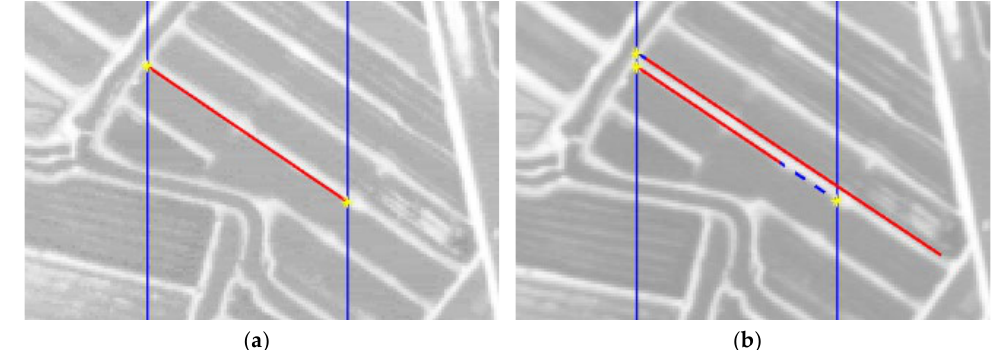
Figure 5. Determining the corresponding segments. ( a ) Reference image; ( b ) search image. The blue lines on both images are the corresponding epipolar lines for the endpoints of the L . The line segment with the intersections of the candidate line and the two epipolar lines as endpoints is the overlapping segment of the candidate line corresponding to the reference line.